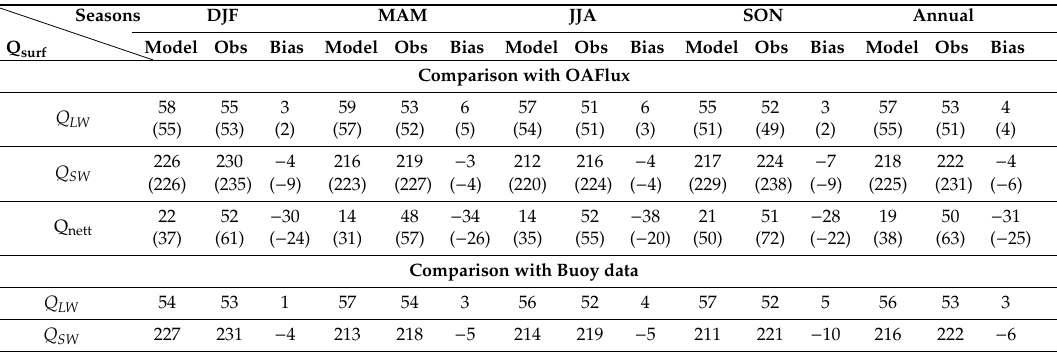
Figure 7. The annual cycle of ( a ) Q SW and ( b ) Q LW at the TAO buoys in the Pacific, ( c ) Q SW at the PIRATA buoys in the Atlantic, and ( d ) Q SW at the RAMA buoys in the Indian Ocean using data from 1997 to 2008. Q LW at the RAMA and PIRATA locations were not plotted because of insufficient data from the buoys during this period. (unit: W m − 2 ).